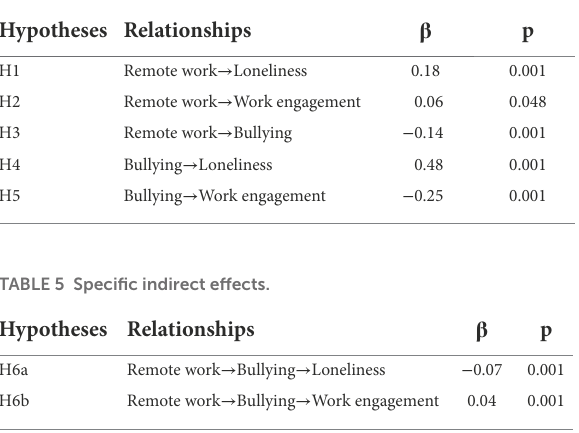
TABLE 4 Standardized path coefficients (direct effects).